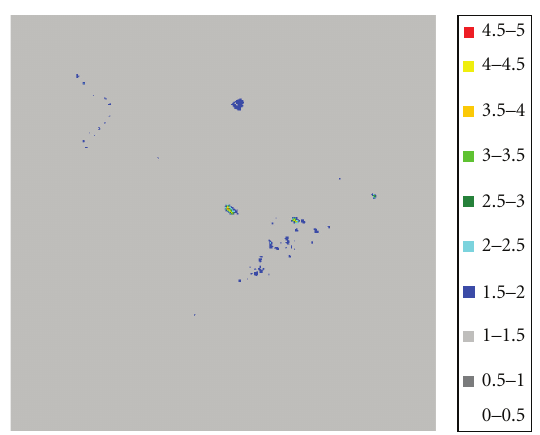
Figure 7: Cost map generated using the simulated LIDAR data. The cost of the vegetation is the same as the cost generated using real data, but the area of cost associated with the vegetation is smaller by roughly 75%.